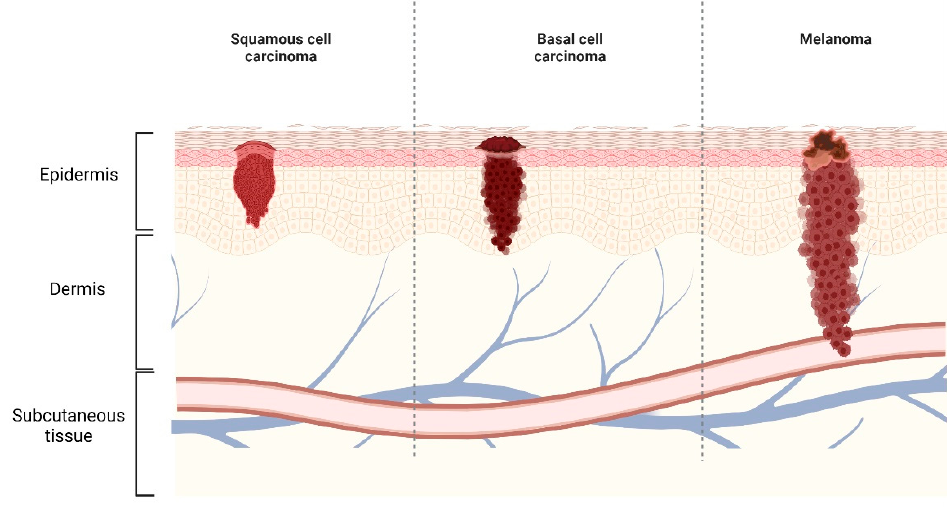
Figure 1. Different layers of the skin and types of skin cancer.